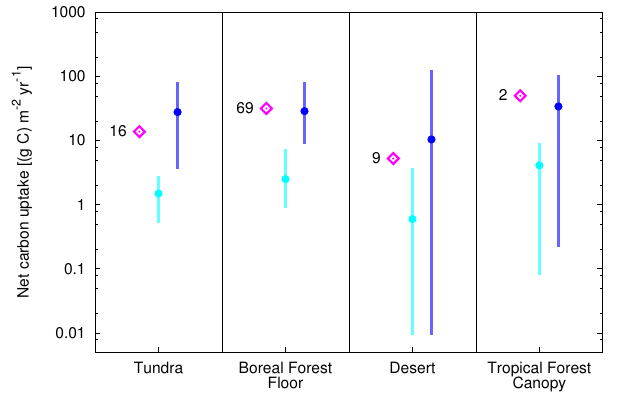
Figure 7: Comparison of net carbon uptake estimated by the model to observational data. A magenta diamond corresponds to the median of the observed values in the respective biome. The number left to the diamond is the number of observed values. See Table 1 for an overview of the studies on which the observations are based. The light blue colour corresponds to the lower bound of the model estimate and the dark blue colour to the upper bound. The vertical bars represent the range between the most and least productive grid cell in a certain biome, while the dots show the mean productivity of all grid cells in this biome. To be consistent with the measurements from the field studies, only the simulated carbon uptake in the canopy was considered for the biome “Tropical Forest” while for the other biomes only carbon uptake on the ground was considered. The model results are derived from a 2000-yr run with 3000 initial strategies.